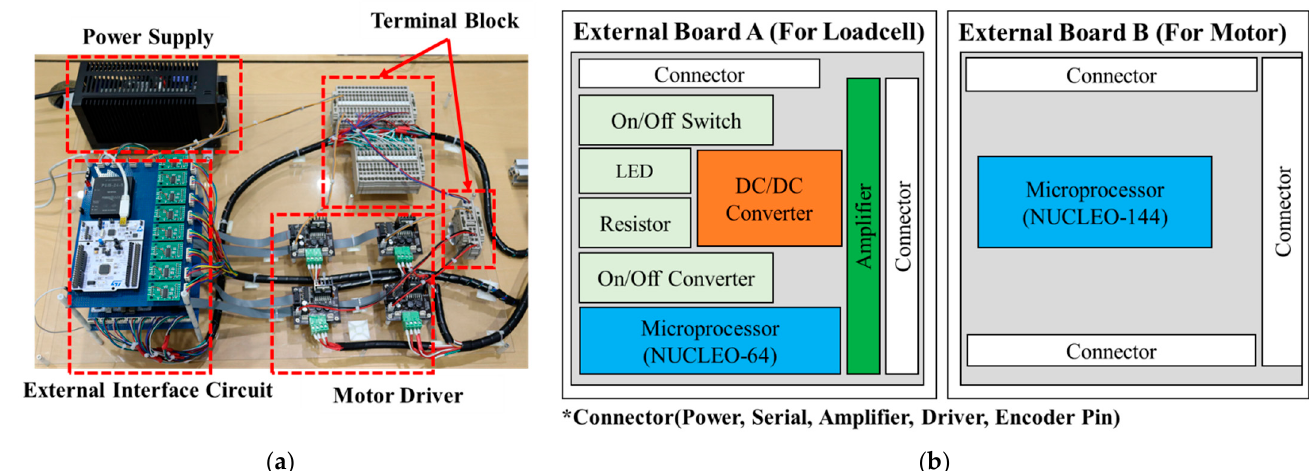
Figure 4. External board setup part of developed system: ( a ) controller part of the developed haptic device; ( b ) schematic of the external board.